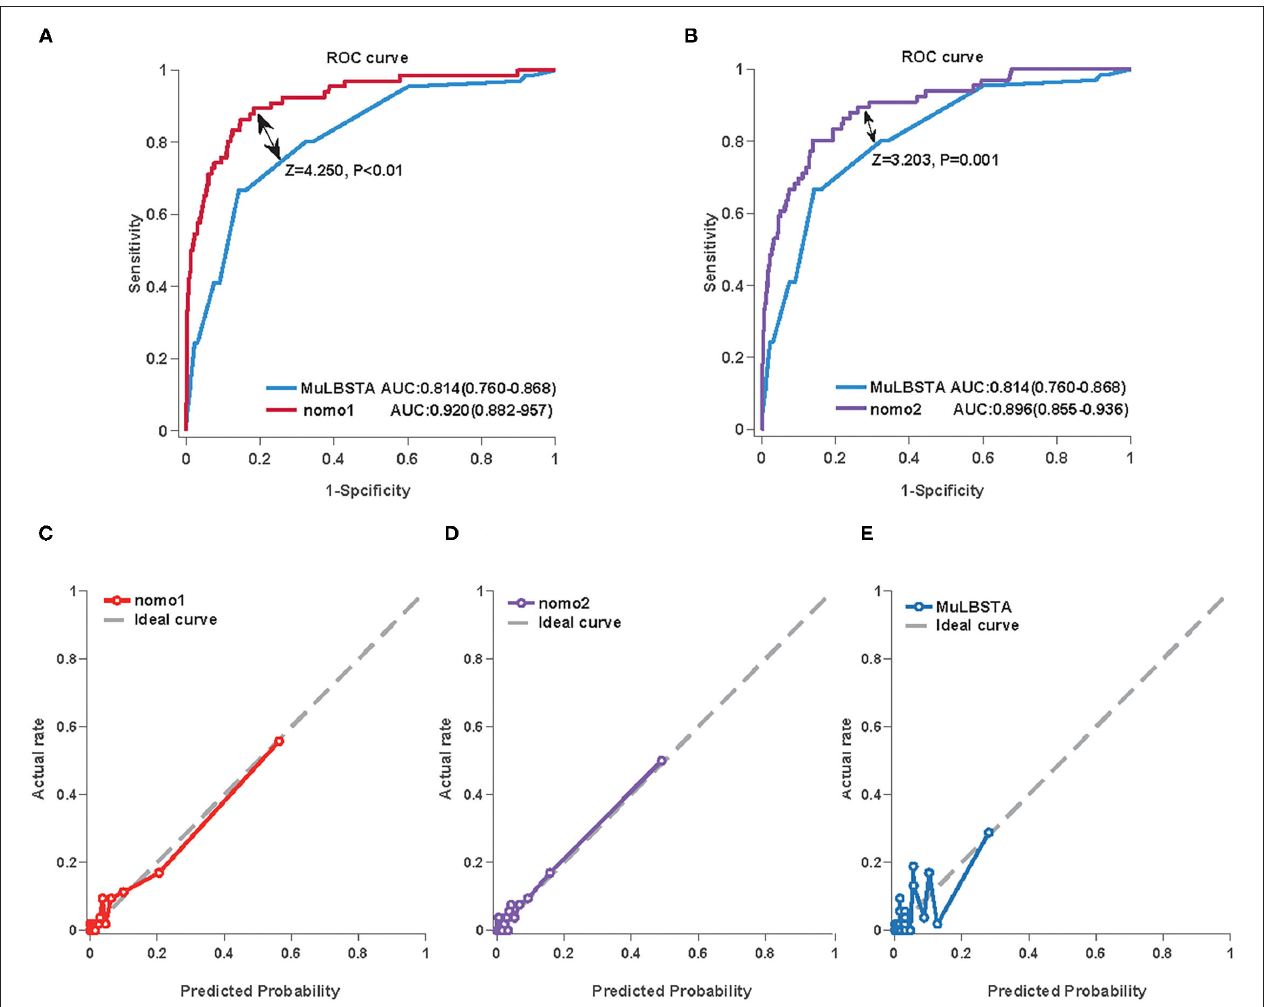
FIGURE 3 | The performance of the Nomo1, Nomo2, and the MuLBSTA score in predicting the mortality of COVID-19 in the training cohort. The area under the curve (AUC) curve analyses were generated to test the discrimination of Nomo1 and the MuLBSTA score (A) or Nomo2 and the MuLBSTA score (B) . The calibration curves were generated for Nomo1 (C) , Nomo2 (D) , and the MuLBSTA score (E) . The dashed line represents an ideal